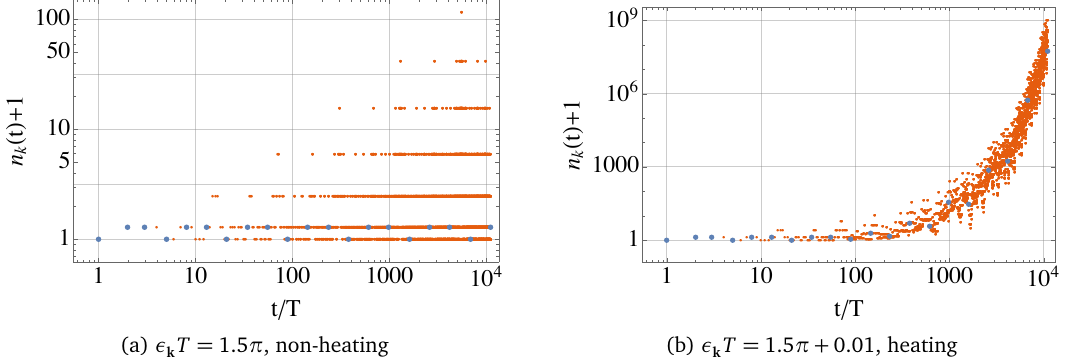
( t ) as a function Figure 4: The Fibonacci modulation of the scattering length: (a). n k ( t ) as T = 1.5 π and E T = 2.5 π without exponential heating. (b). n of t / T for ε k k k T = 1.5 π + 0.01 and E T = 2.5 π with exponential heating. a function of t / T for ε k k T The blue dots are the results at Fibonacci numbers t = q n